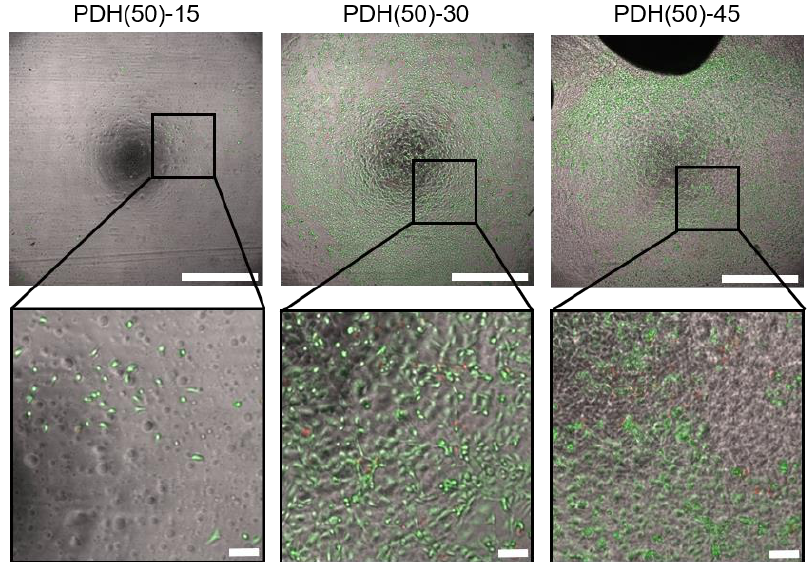
Figure 4. Image of HUVECs cultured on photodegradable hydrogels prepared with Azide-gelatin(50). Scale bar: 1 mm in the left panel and 0.1 mm in the right panel. The bright field and fluorescent images of the cells on the hydrogels were acquired and merged after LIVE/DEAD staining. Green and red colors indicate live and dead cells, respectively. HUVECs adhered and proliferated partially on PDH(50)-15, uniformly on PDH(50)-30, and nonuniformly on PDH(50)-45.